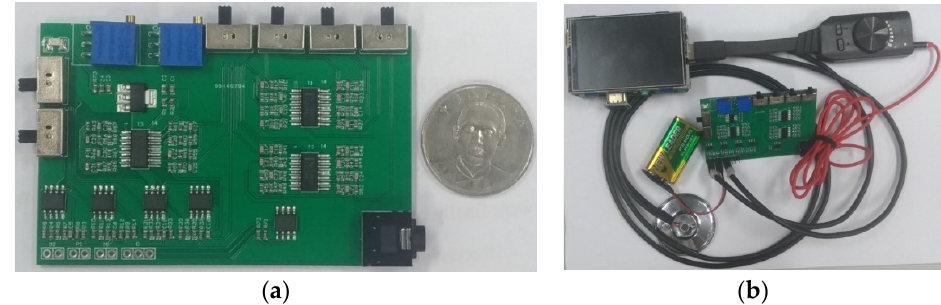
Figure 11. Physical PCB circuit. ( a ) PCB of designed circuit. ( b ) Whole designed system.